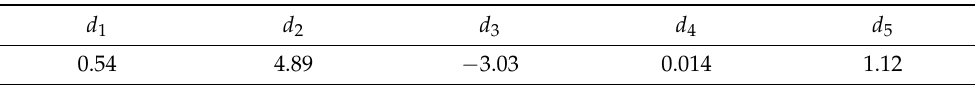
Table 4. Parameters of the J–C failure criterion algorithm for the Cu workpiece used in the FE model